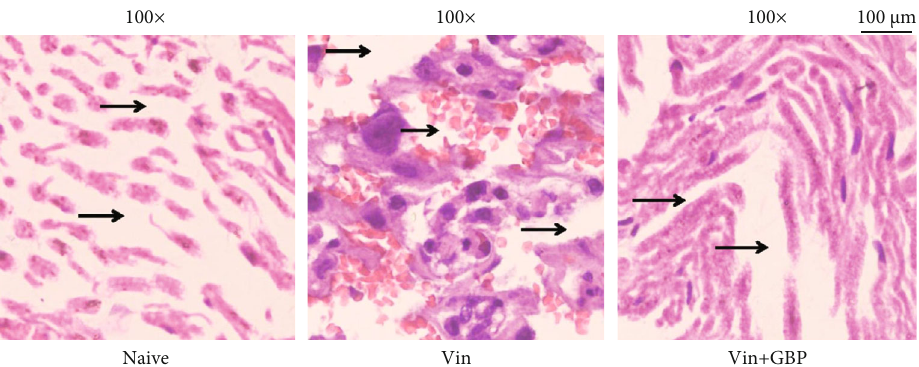
Figure 5: E ff ects of G. elata polysaccharides (GBP) on histopathological changes of the sciatic nerve in Vin-induced neuropathic pain (C). The black arrows indicated neuron gaps and fi ber arrangement. Sciatic nerve tissues were stained using the H&E method and observed under light microscopy (100x). Scale bar = 100 μ m.